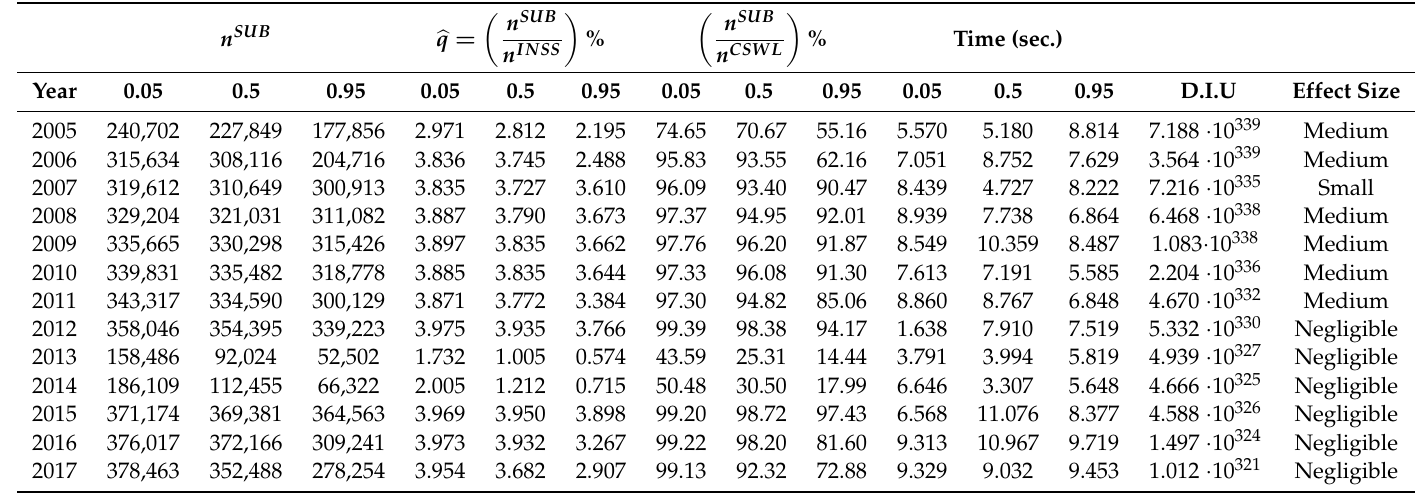
Table 2. Summary of results by pValue min %. Source: own. D.I.U.: Dimension of the Integer Unrestricted problem. Number of combinations of integer values that the pensioner strata may take, within their bounds but without requiring the constraint that the null hypothesis of the statistical test is not